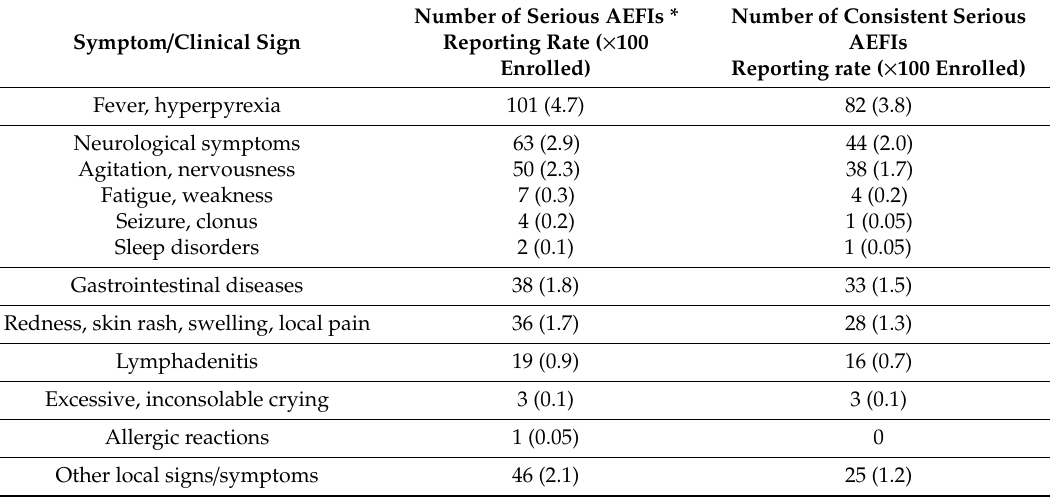
Table 2. Number and reporting rate of symptoms / clinical signs most frequently notified in